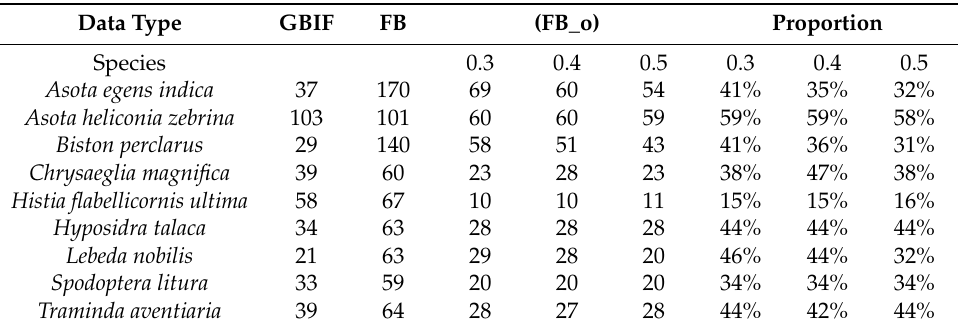
Table 1. The number of observations in GBIF, FB, FB_o, as well as the proportion of the number of observations in FB_o to the number of observations in FB.